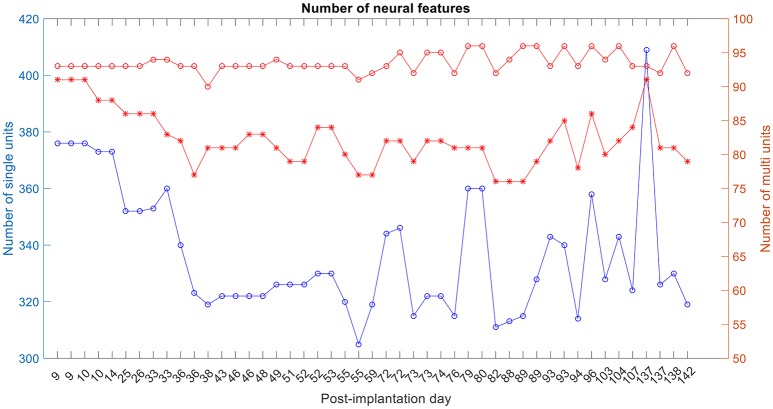
Number of single-unit features, multi-unit features and number of active electrodes with any neural activity. The blue plot corresponds to the number of isolated single units, red-asterisk plot corresponds to the number of active electrodes with multi-unit activity and the red-circle plot corresponds to the number of active electrodes with any neural recording (single and/or multi-units).